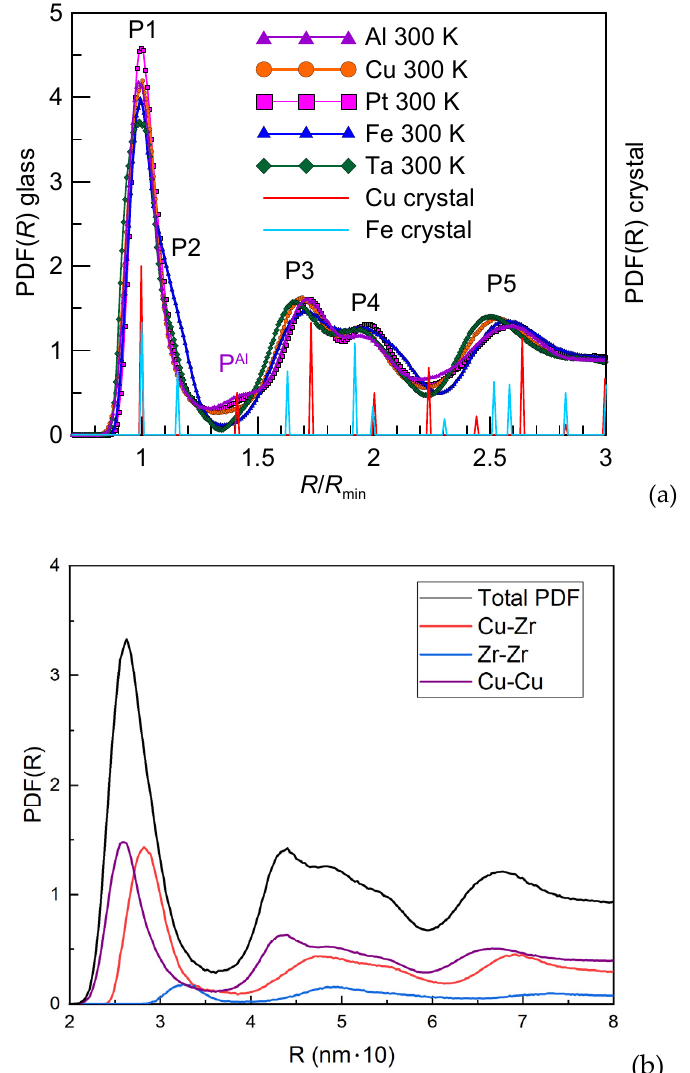
Figure 2. ( a ) PDF(R) glass of glassy Al, Cu, Fe, Pt and Ta as a function of radial distance ( R ) divided by the nearest interatomic distance ( R min ) in the corresponding crystal on the left side Y axis and PDF(R) crystal of the corresponding crystal: Cu as a representative of FCC one and Fe of a BCC one on the right side Y axis. ( b ) Partial and total PDF(R) s of the Cu 80 Zr 20 alloy cooled at 10 12 K/s (MD simu- lation).